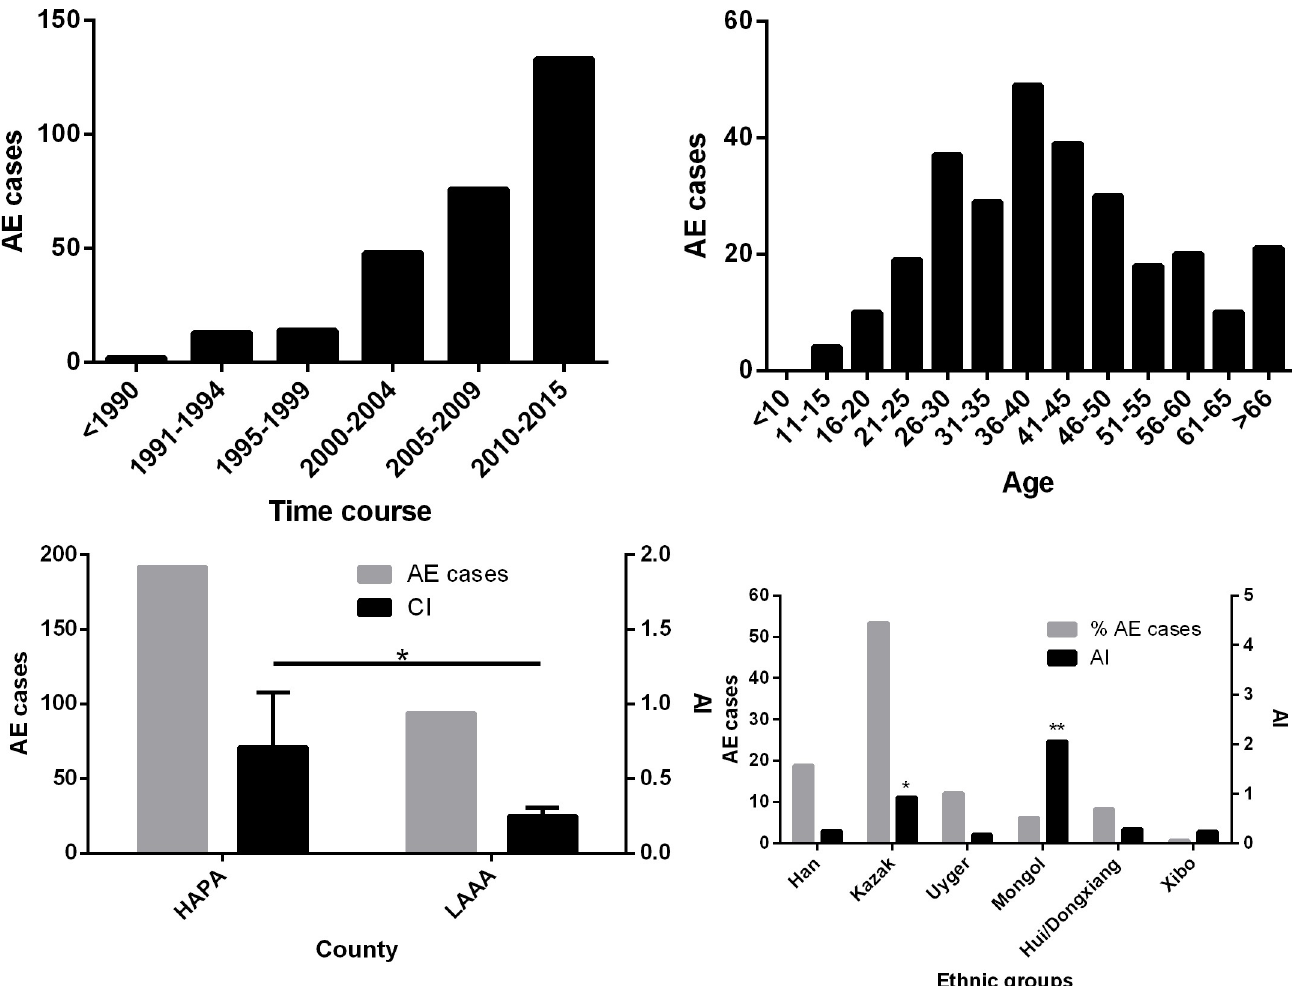
Fig 2. Distribution of alveolar echinococcosis (AE) cases in Yili Prefecture, Xinjiang. (a) Number of AE cases since 1989; (b) AE cases in different age groups; (c) AE cases and average annual incidence (AI, cases/100,000) between the high altitude mountainous pasture area (HAPA) and the low altitude mountainous agricultural area (LAAA); (d) AE cases and AI in different ethnic groups. An asterisk indicates a significant